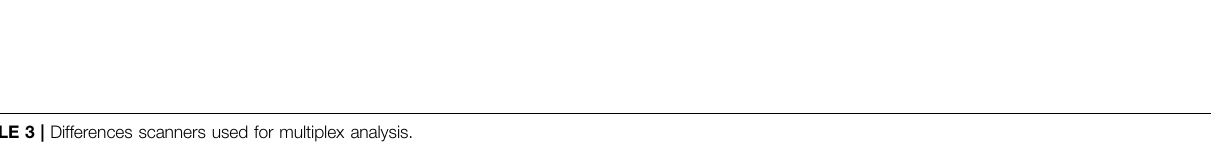
FIGURE 3 | Spectral library creation with the different fl uorophores from the Opal-9 kit. Opal 480, Opal 520, Opal 540, Opal 570, Opal 620, Opal 650, and Opal 690, Opal 780, and DAPI were stained, optimized, and validated until we obtained similar dynamic ranges and speci fi c wave peaks as is possible to see in this